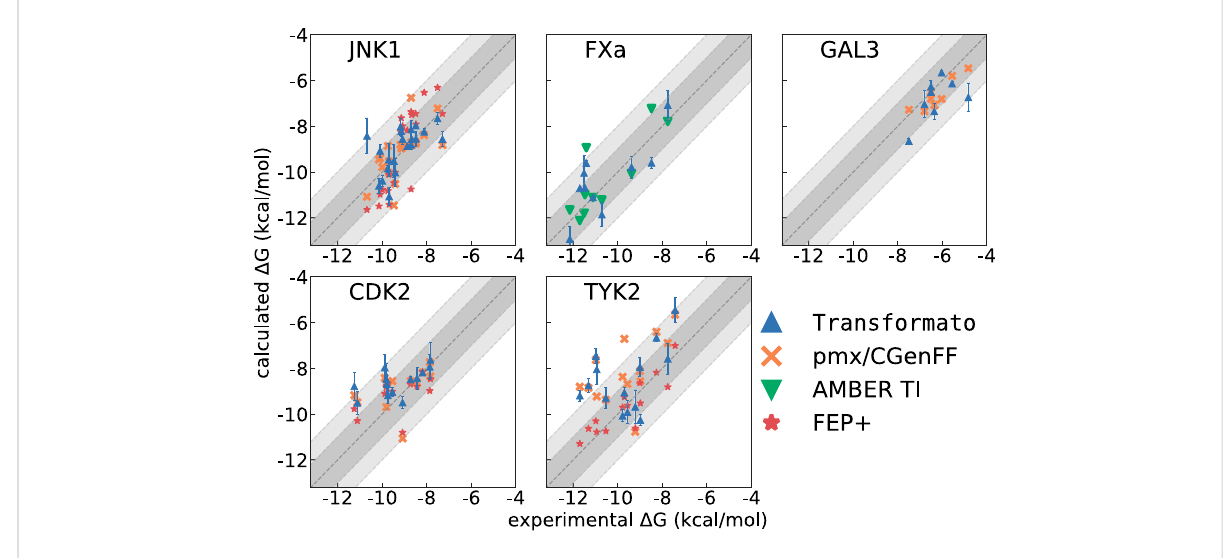
FIGURE 3 Δ G bind calculated with transformato (blue triangles) compared to results obtained by pmx/CGenFF (for JNK1, GAL3, CDK2, TYK2) marked as orange crosses, by FEP+ (for JNK1, CDK2, TYK2) marked as red stars, and by AMBER (FXa) marked as green triangles. The respective RMSE and MAE values are listed in Table